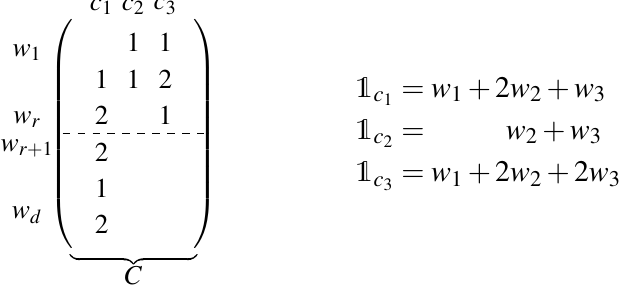
Figure 2: An example of the matrix M | C in the field F 3 , where blank entries denote 0. The column c = c 1 falls into Case 1., c 2 falls into Case 2., c 3 falls into Case